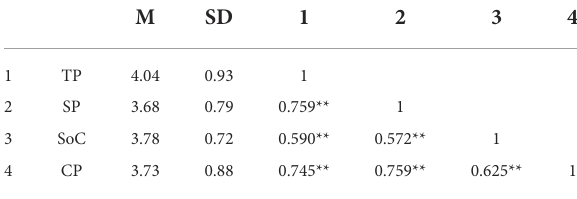
TABLE 1 Descriptive statistics and Pearson’s correlations (N = 215).